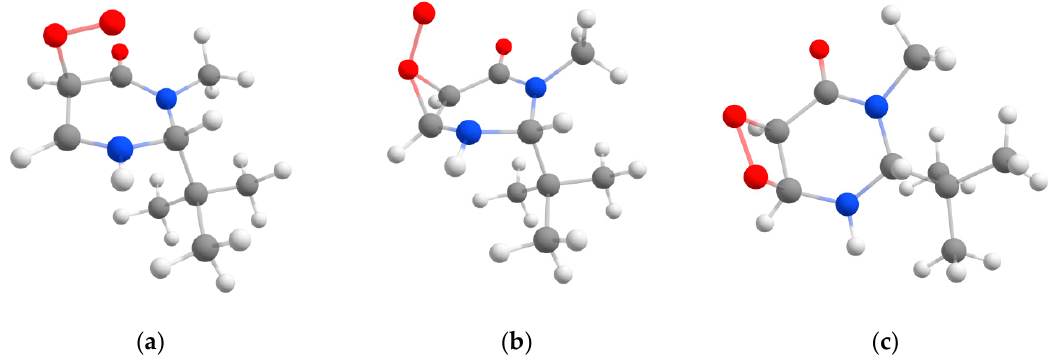
Figure 8 . The proposed intermediates studied of the peroxidation reaction: ( a ) Biradical or zwitterion (dipolar), ( b ) perepoxide, and ( c ) 1,2-dioxetane.